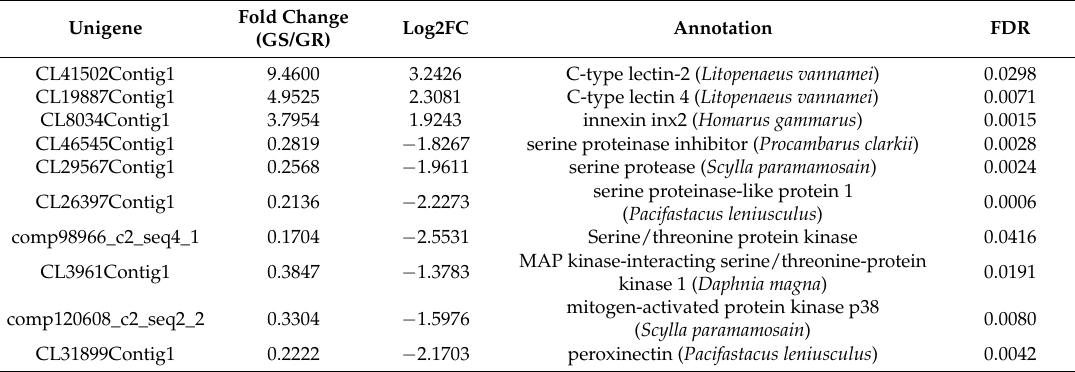
Figure 2. The number of differentially expressed genes (DEGs) from pairwise comparison in three Procambarus clarkii groups. The histogram graph showed the number of DEGs in each pairwise comparisons ( A ); Three-way Venn diagram of all evidencing numbers of the DEGs identified in the three comparisons ( B ). Table 2. The candidate genes involved in the antiviral response for P. clarkii